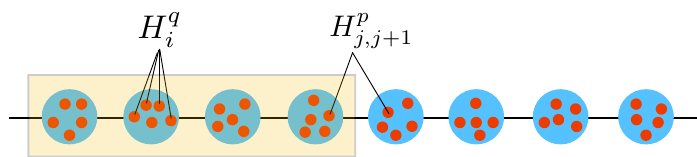
Figure 1: The cartoon for the non-Hermitian SYK model. The H q represents the intra- i cluster SYK model and the H p represents the inter-cluster SYK coupling term. We j , j + 1 compute Rényi entropy of a single interval in the